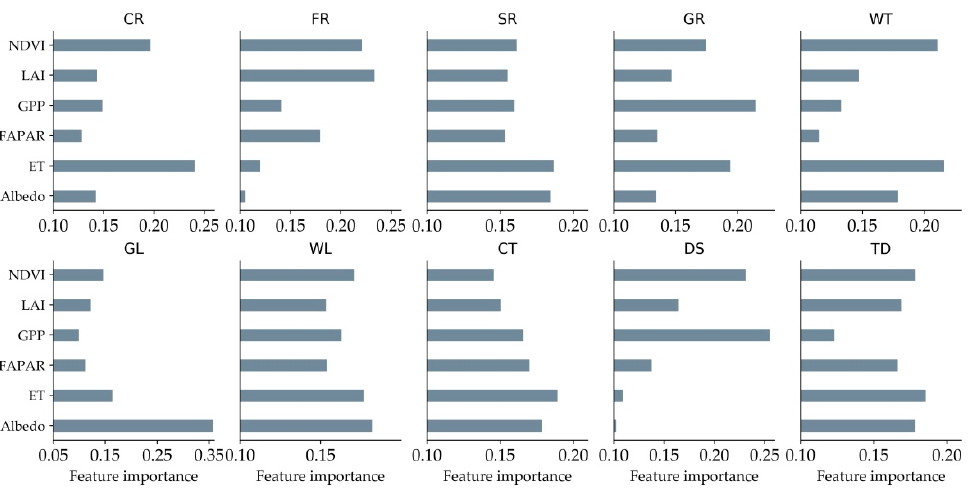
Figure 10. Characteristic importance of each category.